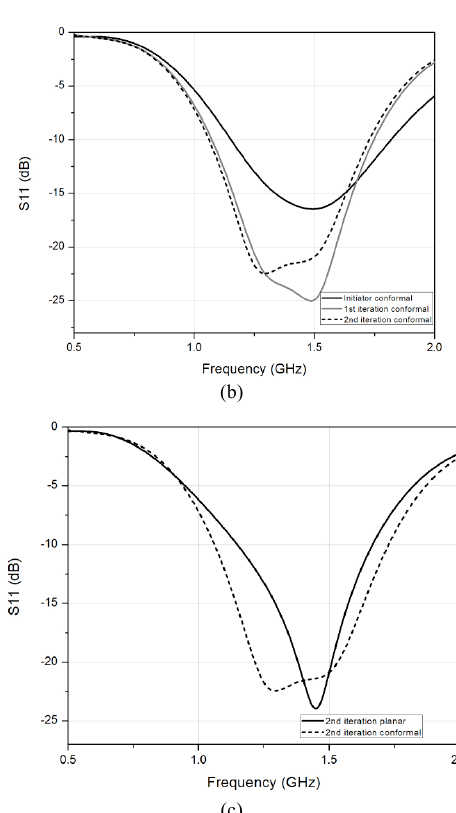
Figure 4: The simulated magnitude of the reflection coefficient.